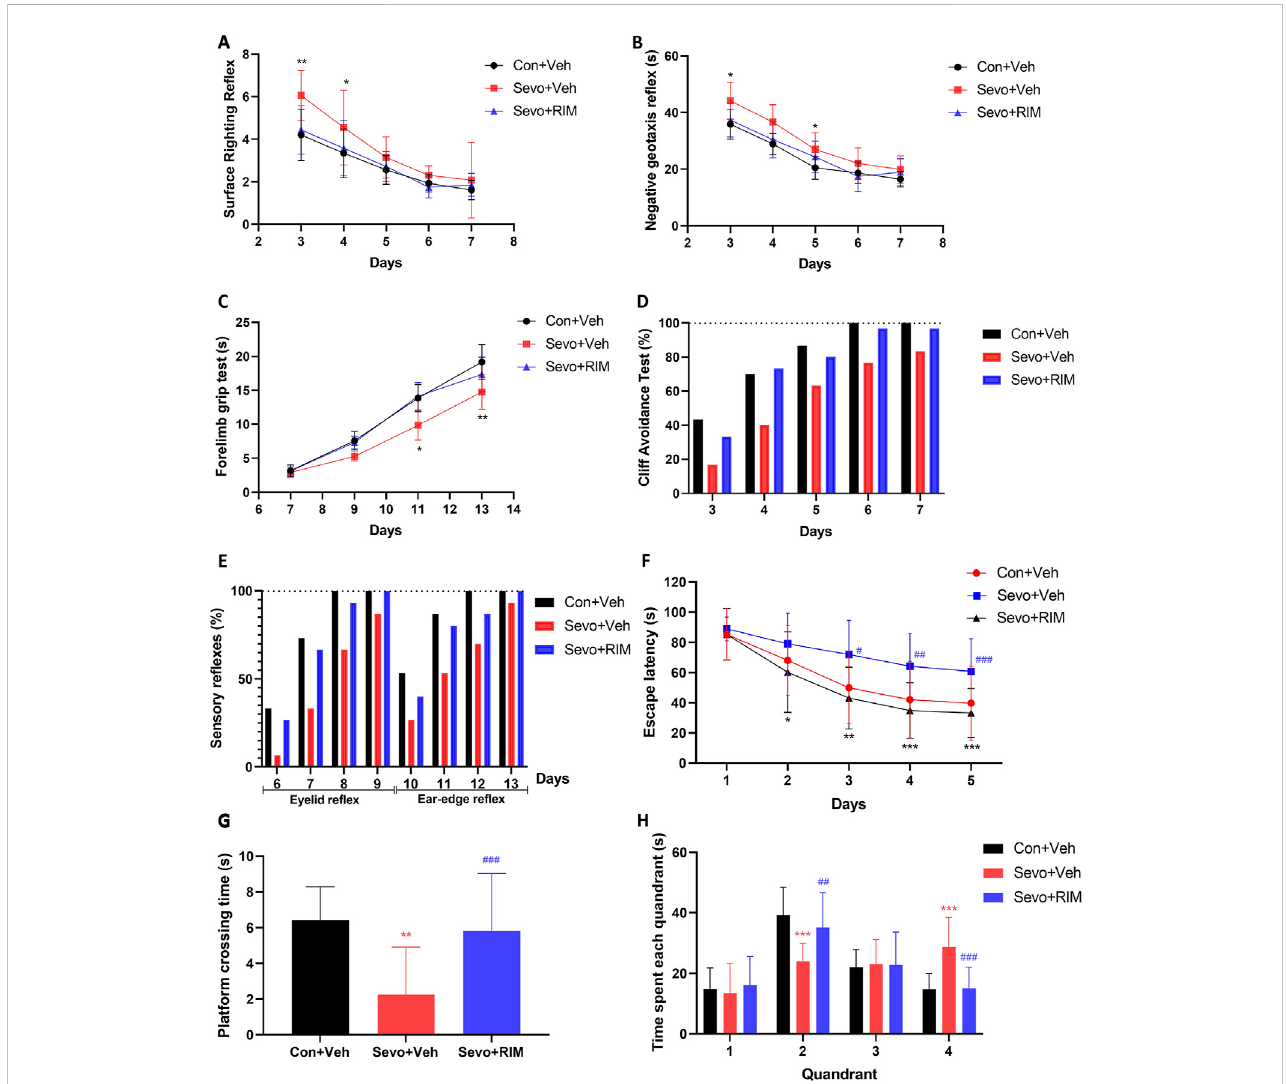
FIGURE 2 Maternal sevo fl urane exposure caused dysfunction in neurobehaviors and cognitive memory in neonatal rats. Neurobehavioral tests ( n = 12 per group) were performed during P3 – 13 and included surface righting re fl ex (A) , negative geotaxis re fl ex (B) , forelimb grip test (C) , cliff avoidance test (D) , and sensory re fl exes (E) . The MWM tests ( n = 12 per group) were carried out during P28 – 33. Escape latency (F) , the times of crossing the platform (G) , and time spent in each quadrant (H) were recorded. Data are depicted as mean ± S.E.M. * p < .05, ** p < .01, vs. the Con + Veh group; # p < .05, vs. the Sevo + Veh